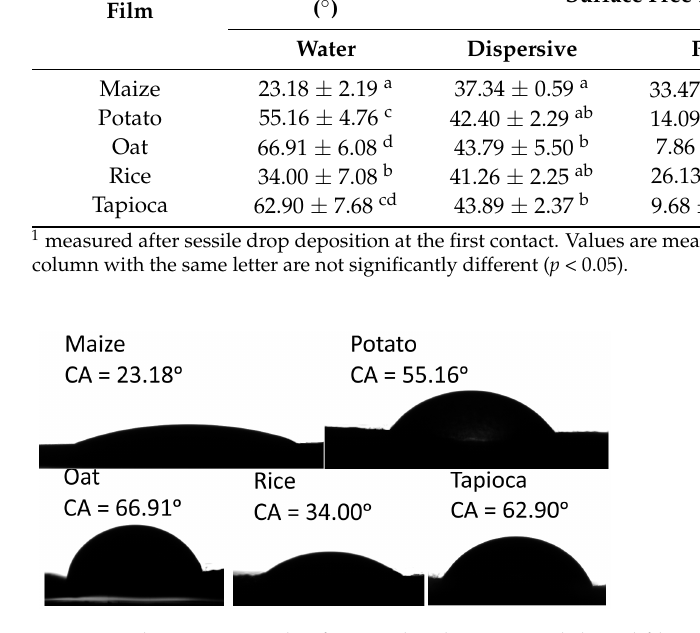
Figure 2. The contact angle of water droplets on starch-based films.